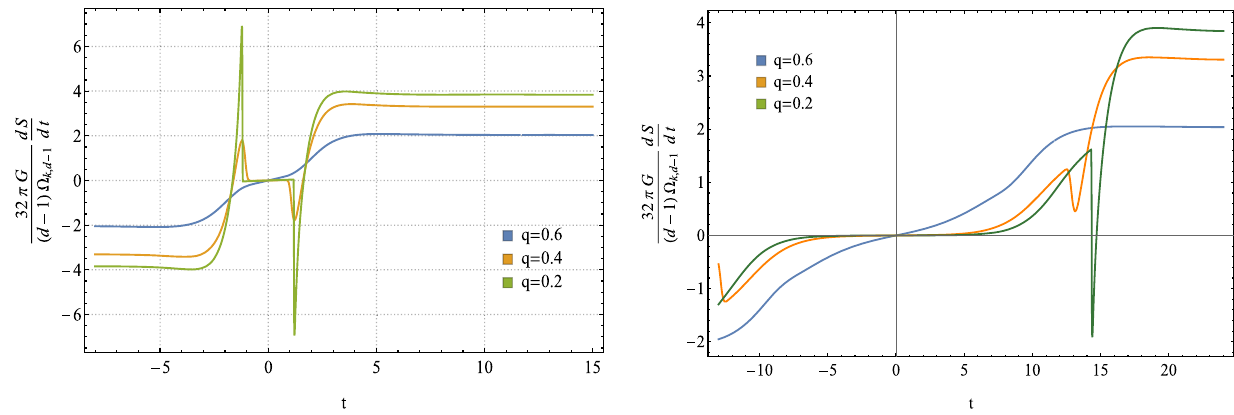
Fig. 5 The action growth rate for the light shock wave with the symmetric time evolution as t L = t R = t / 2 with t w = 5 (left) and t w = 14 (right). We have set d = 3 , k = 0 , l ct = 1 , L = 1 , q = 0 . 6 ,ω 1 = 1 ,ω 2 = 1 + 10 − 4